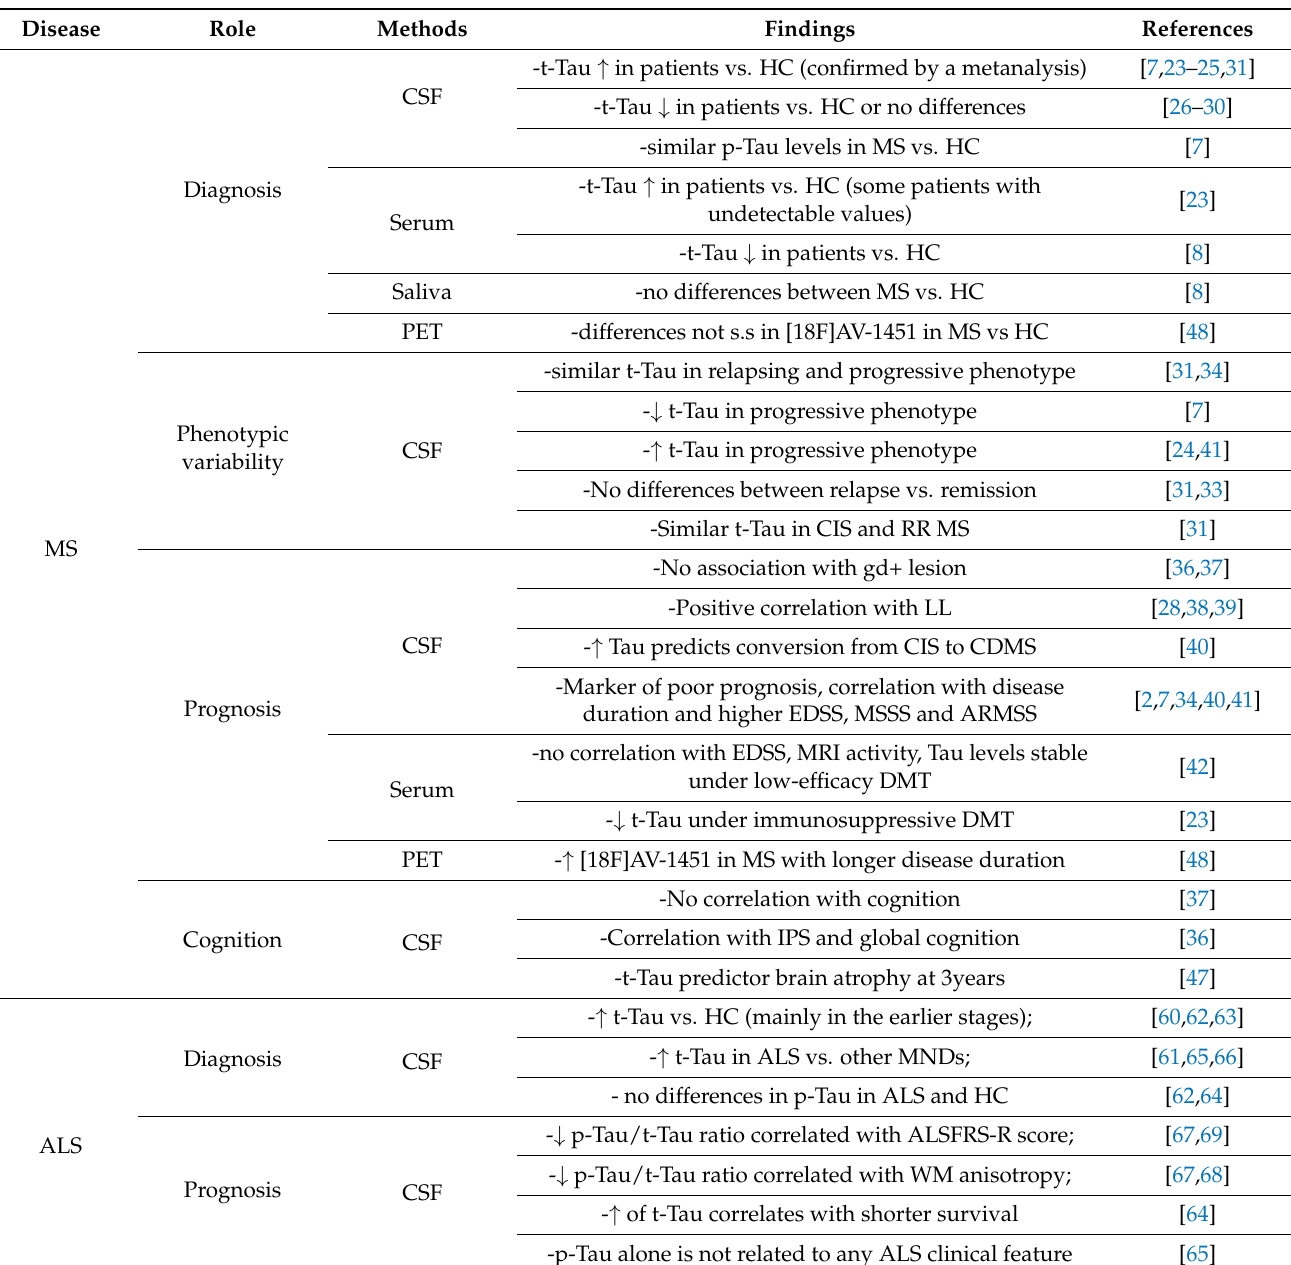
Table 1. Overview of the principal findings regarding Tau protein in non-AD neurodegenerative